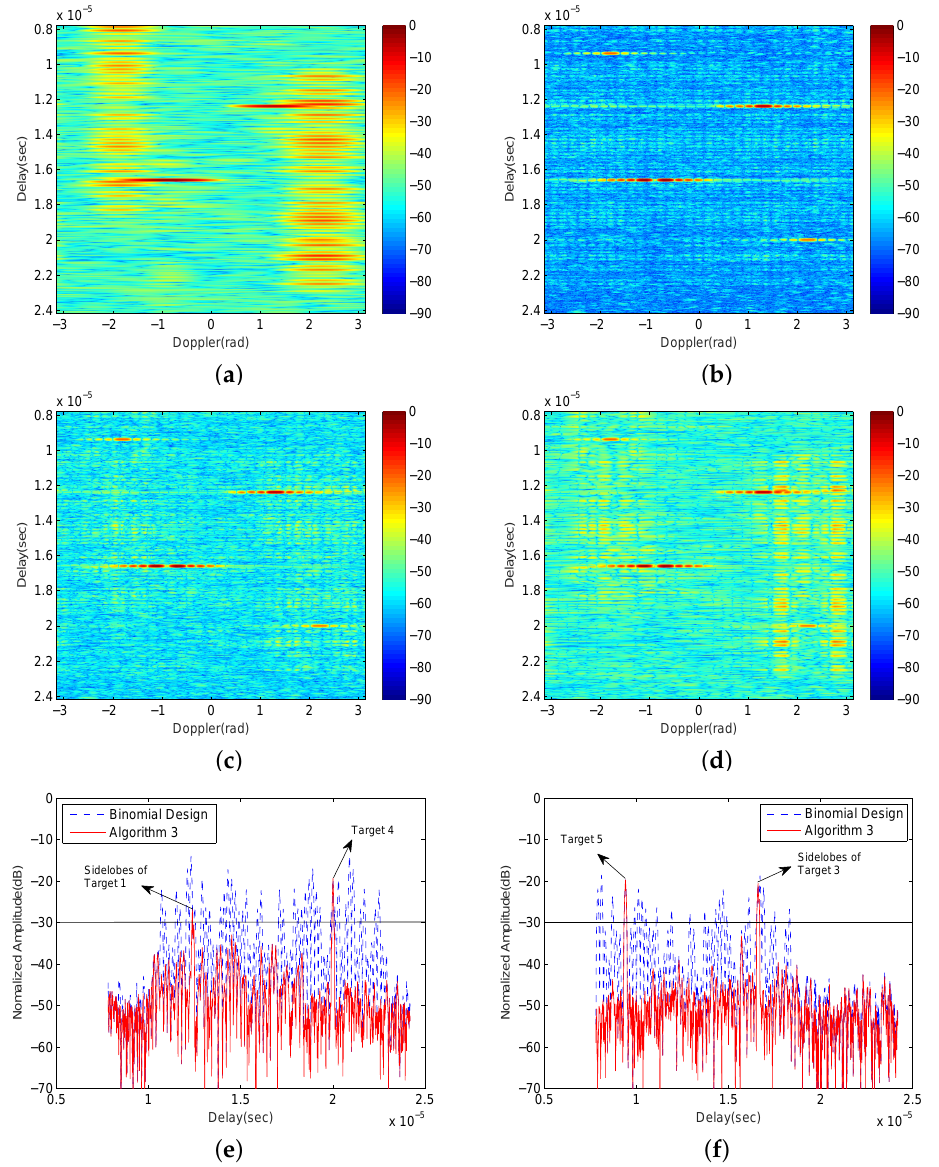
Figure 8. The output Delay–Doppler maps of ( a ) Binomial Design algorithm; ( b ) Algorithm 1; ( c ) Algorithm 2; ( d ) Algorithm 3 in the particular set target detection scene; and the comparisons of Doppler cross sections of the weak targets ( e ) Target 4; ( f ) Target 5 for Binomial Design algorithm and Algorithm 3 (the unit of colorbar is